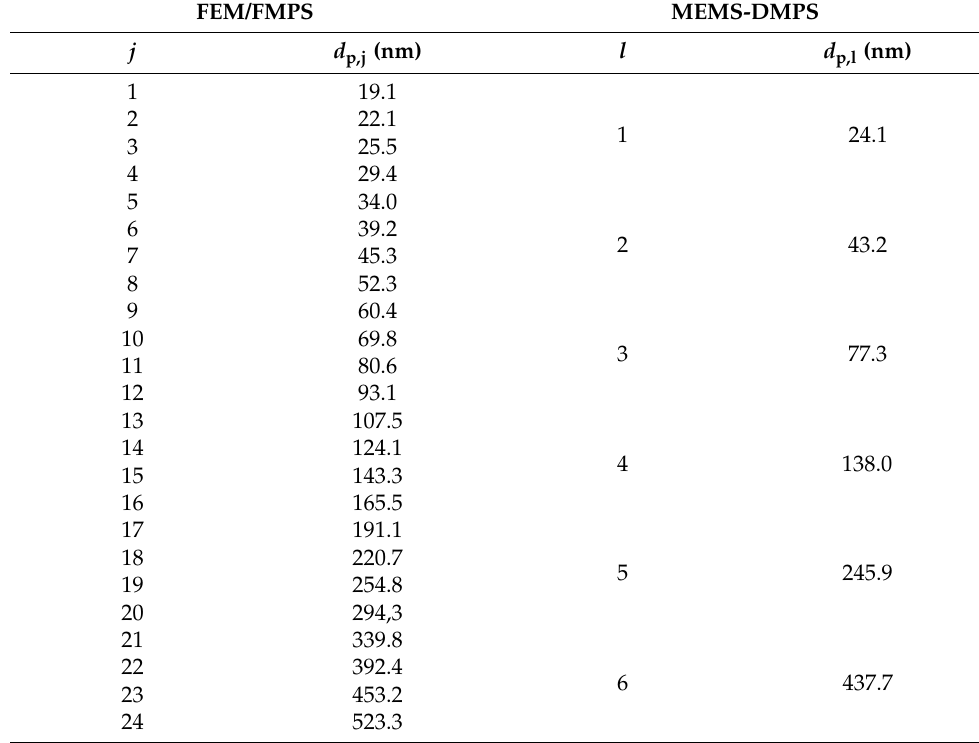
Table A4. Numbering of size bins of FEM/FMPS and MEMS-DMPS ( j , l : Number of particle size bin, d p,I,k : average particle diameter in bin no. j , l